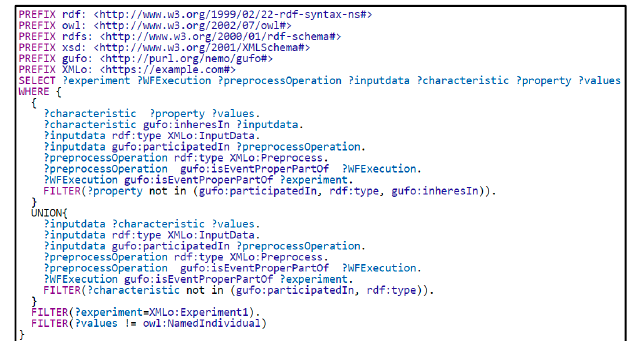
Figure 5. SPARQL query for CQ1 for the first experiment.